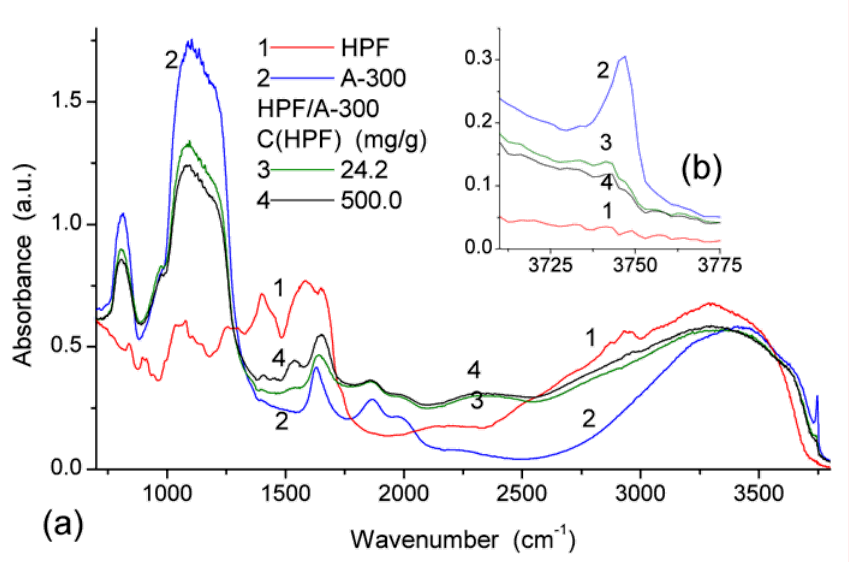
Fig. 4 (a) FTIR spectra of powder HPF, A-300 individual and with adsorbed HPF (pH 7.4, PBS), and (b) OH stretching vibrations of silanols at 3748 cm − 1